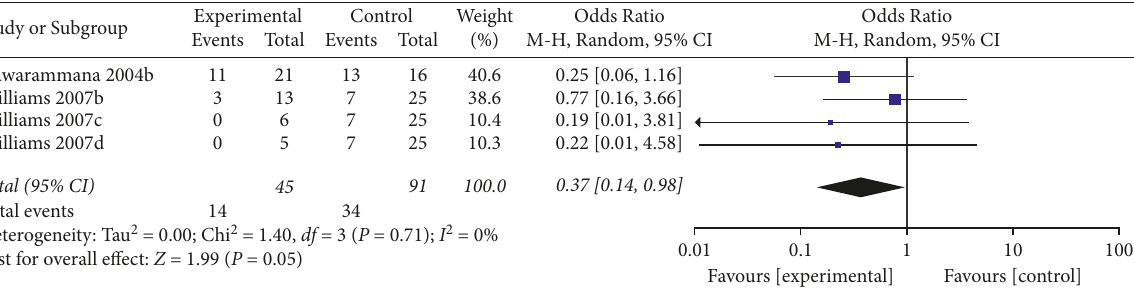
Figure 6: Sensitivity analysis of ADRs associated with antivenom use following snakebite between the prehydrocortisone with other drugs groups and placebo or no premedication groups in four comparisons from two studies.